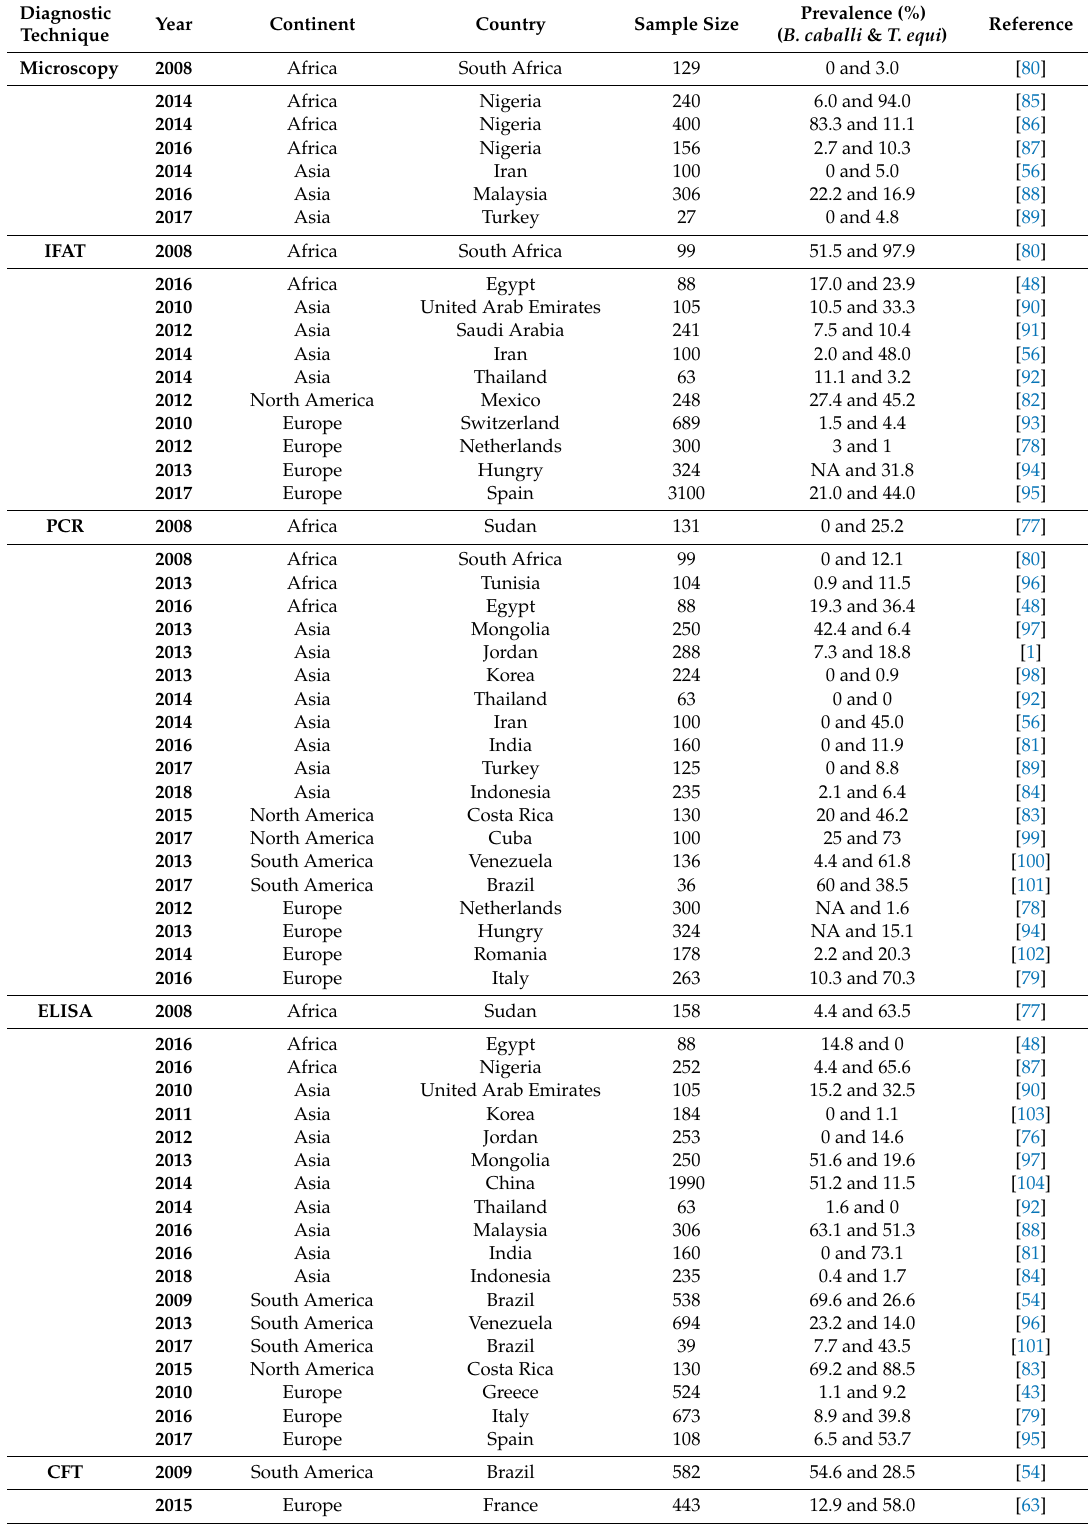
Table 1. Prevalence of equine piroplasmosis in horses in endemic continents and countries using di ff erent diagnostic methods